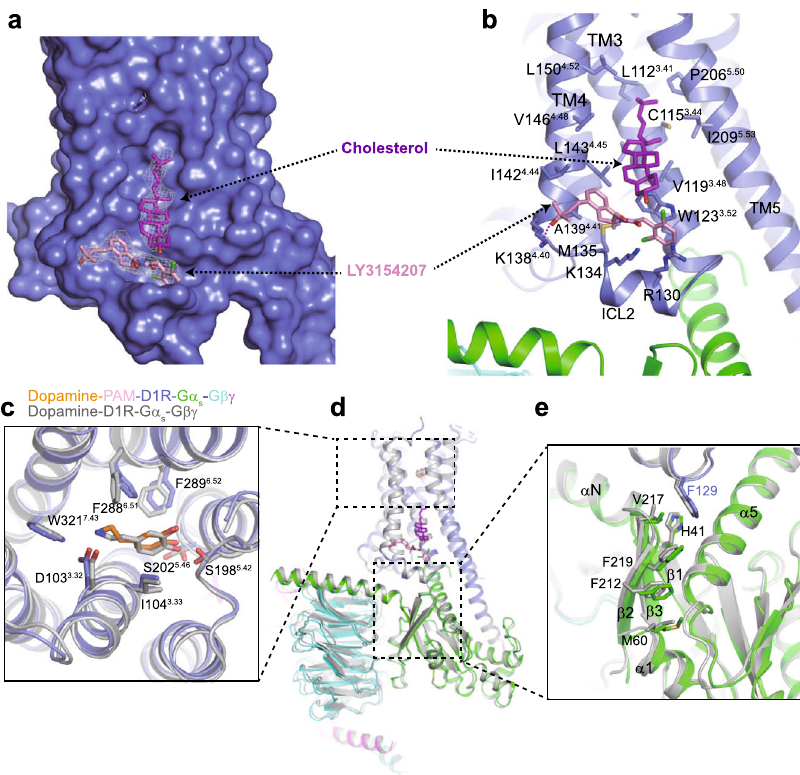
Fig. 4 Allosteric modulation of D1R by PAM. a Surface representation of D1R. EM densities for LY3154207 and cholesterol are shown. b Detailed interactions between LY3154207, cholesterol, and the receptor. Residues involved in binding are shown as sticks. c – e Structural comparison of the dopamine-LY3154207-bound D1R with D1R bound to dopamine